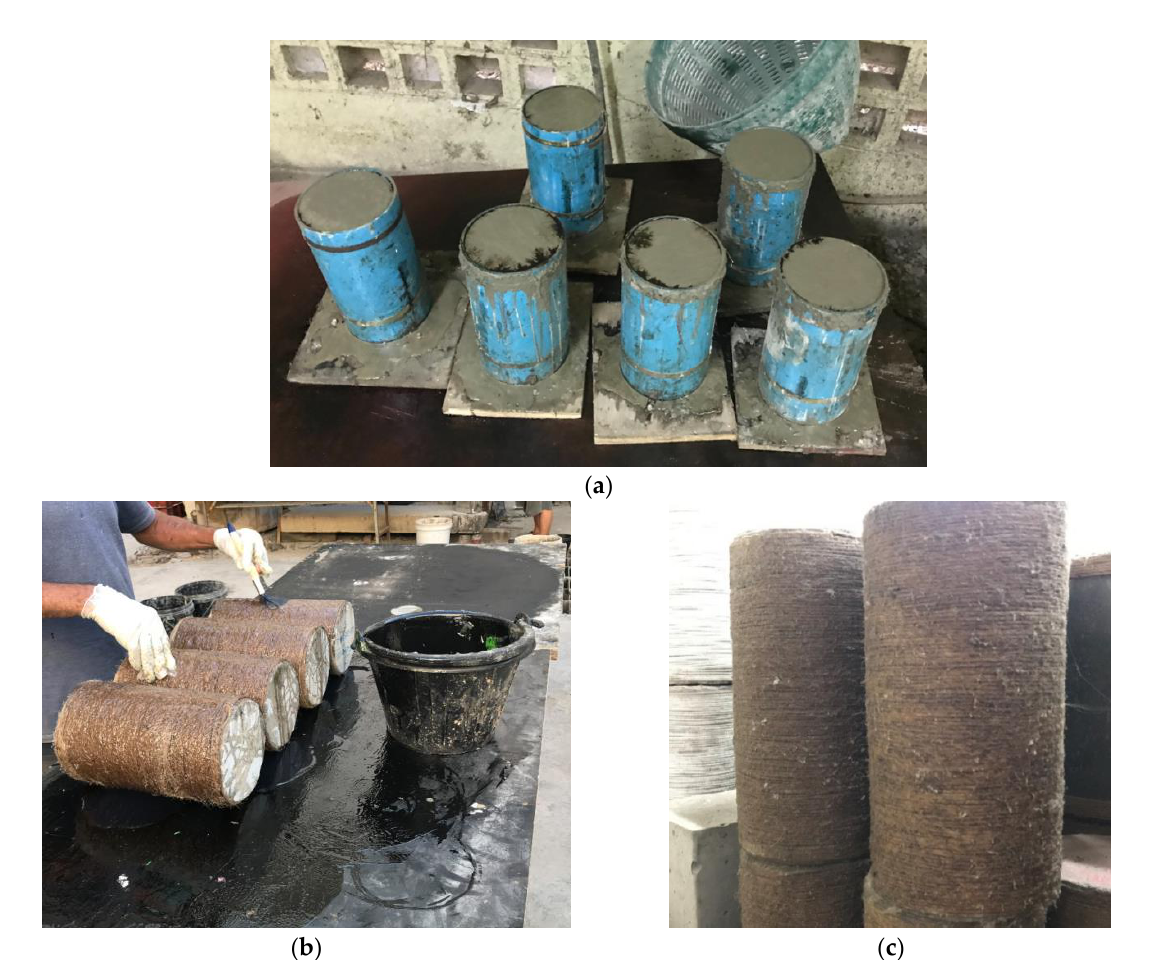
Figure 5. ( a ) Construction of specimens, ( b ) application of two-part epoxy and hemp ropes to cylin- drical specimens, and ( c ) HFRP-confined specimens. cylindrical specimens, and ( c ) HFRP-confined specimens.